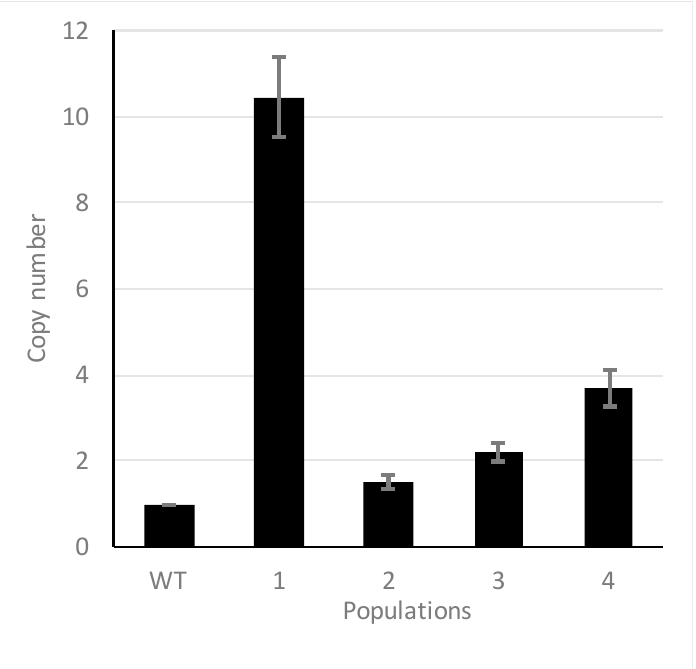
Figure 2. Analysis of the copy number of the amplified region by real-time PCR. Copy number of the amplified region was estimated measuring the amount of BN49-RS11300 present in each population and considering that the wild-type strain presents one copy of the gene. The figure shows the average and standard deviation of copy numbers for each of the populations. In all cases, the differences were statistically significant ( p < 0.05).